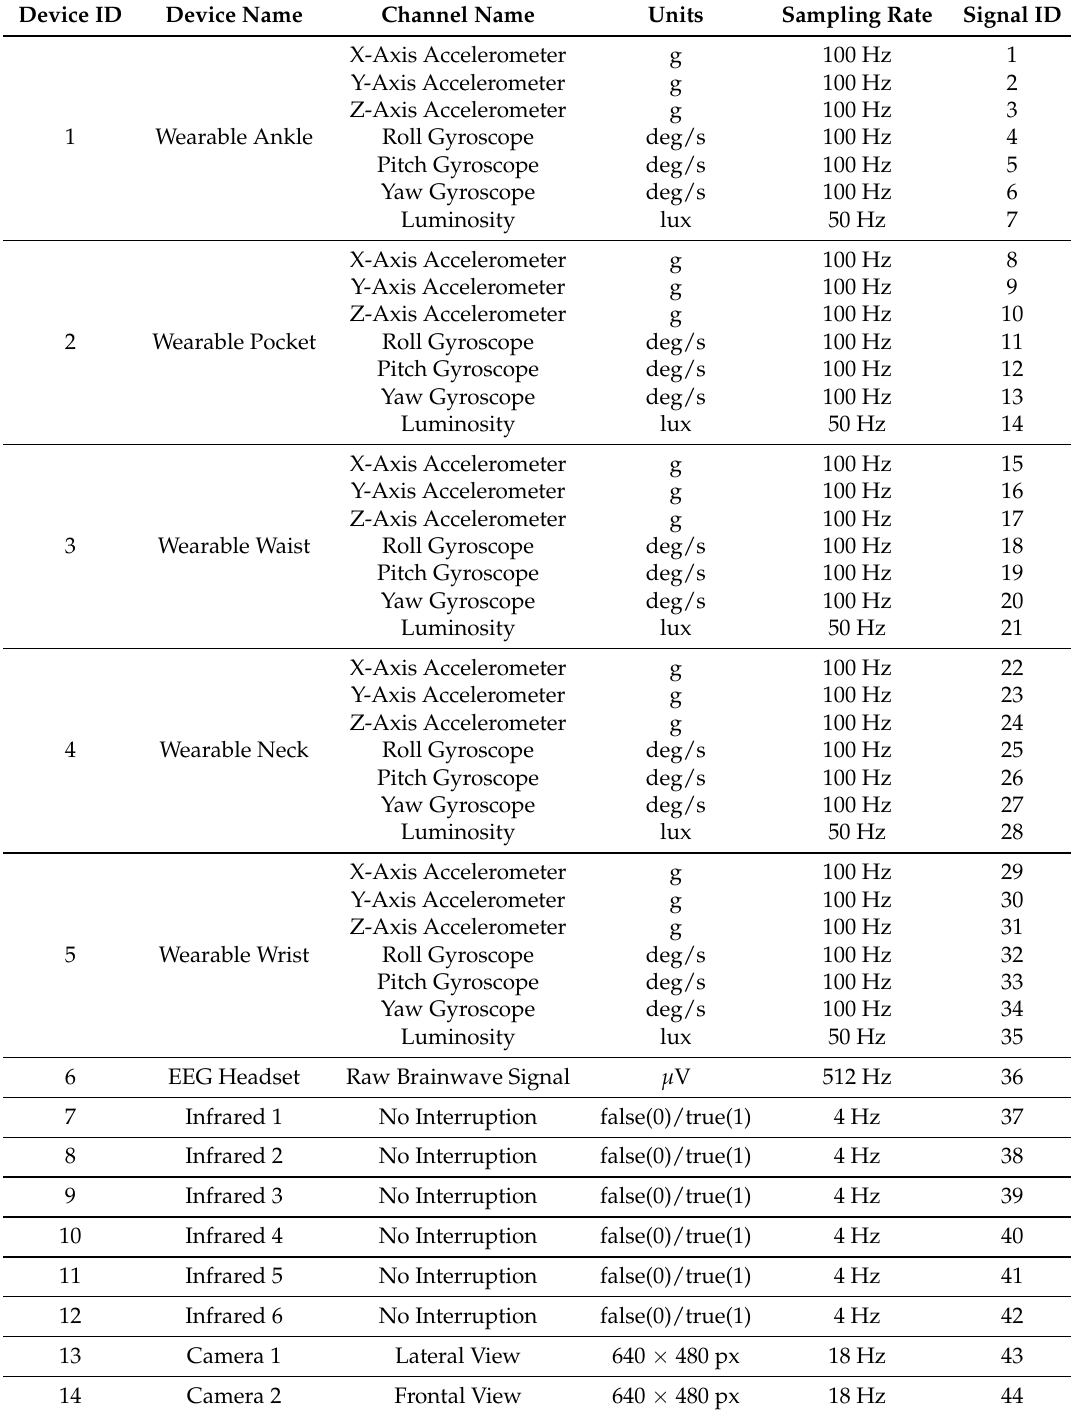
Table 6. List of devices for